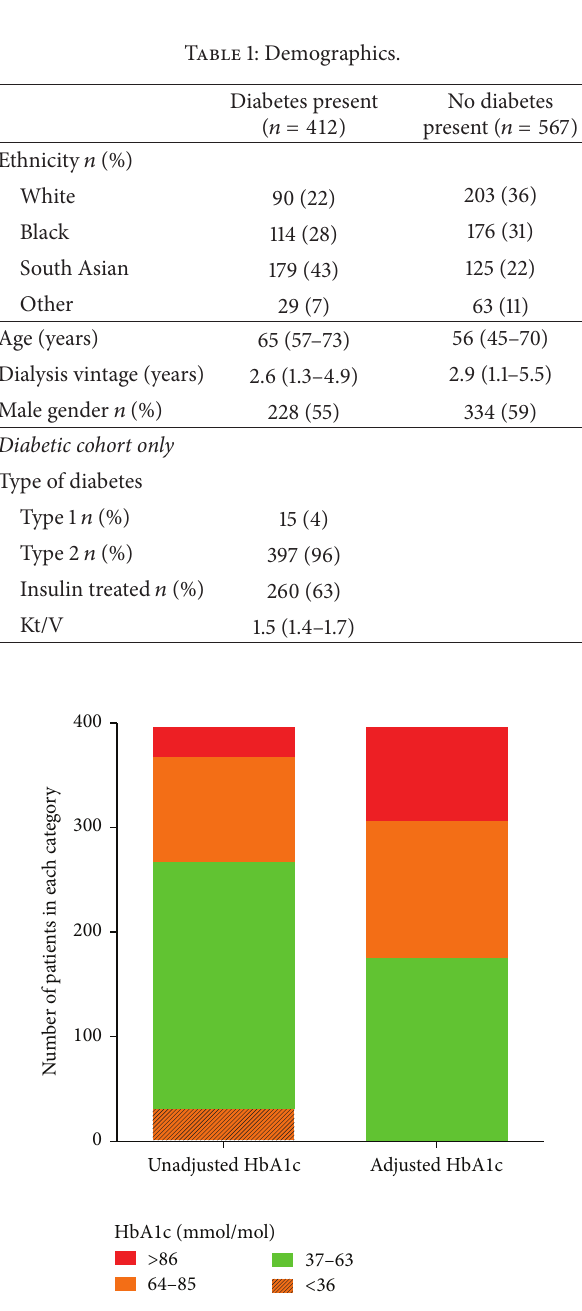
Figure 1: Glycaemic control assessment using HbA1c adjusted for albumin and